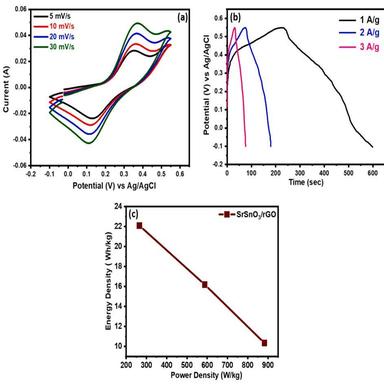
(a) CV of SrSnO3/rGO nanohybrid, (b) GCD of SrSnO3/rGO nanohybrid and (c) power density vs energy density.